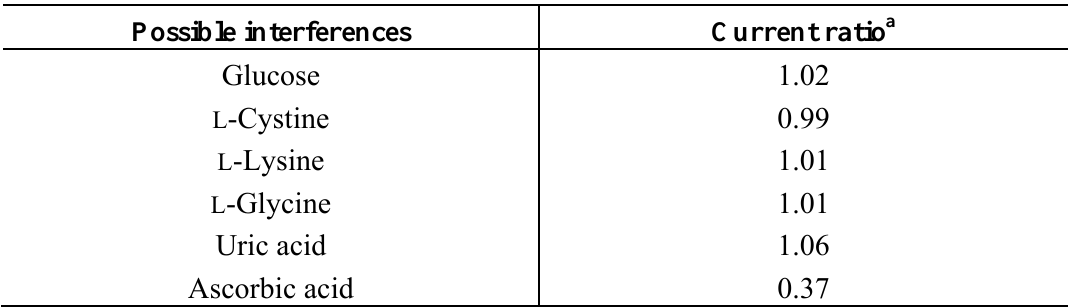
Table 1. Determination results of possible interferences tested with the